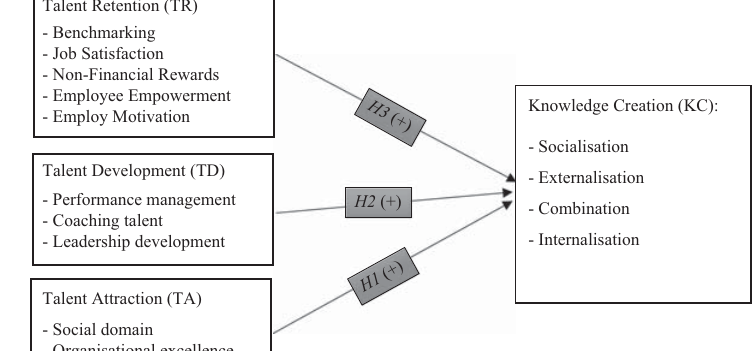
Figure 1. The conceptual